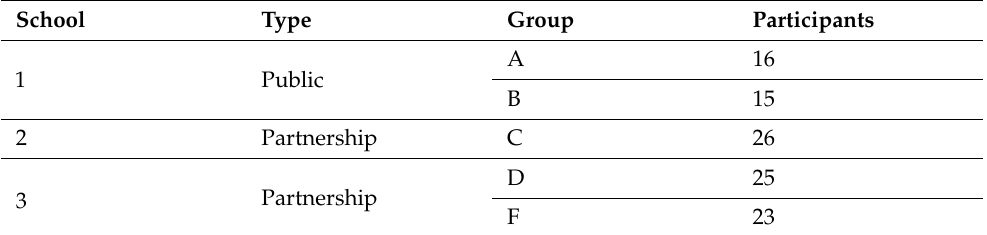
Table 1. Schools and students participating in the study.